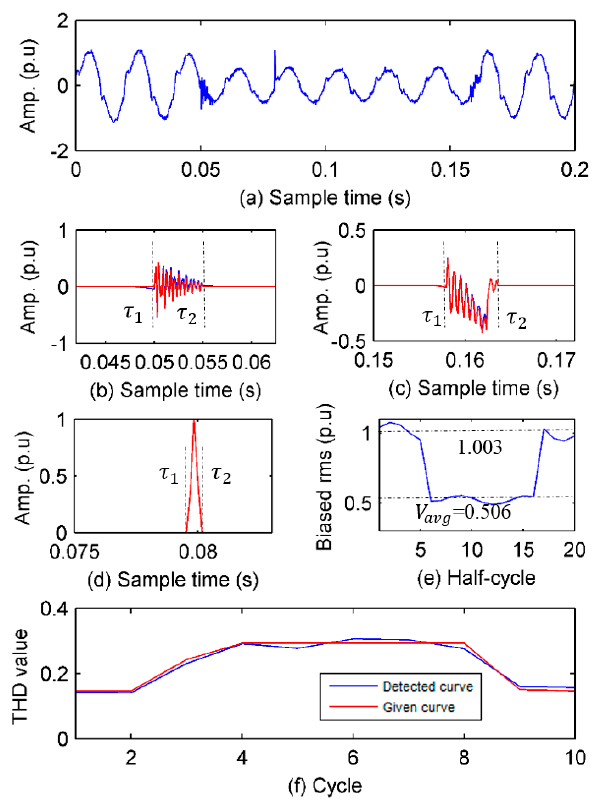
Figure 3. The JDM results of the MPD. ( a ) Waveform of simulation signal; ( b ) Recovery of extracted oscillation 1; ( c ) Recovery of extracted oscillation 2; ( d ) Recovery of extracted impulse; ( e ) RMS envelope of fundamental; ( f ) THD value of each cycle. Deg.: degree, RMS: root-mean-square, THD: total harmonic distortion. Table 4. A comparison between JDM and sparse signal decomposition (SSD) on parameter estimation.